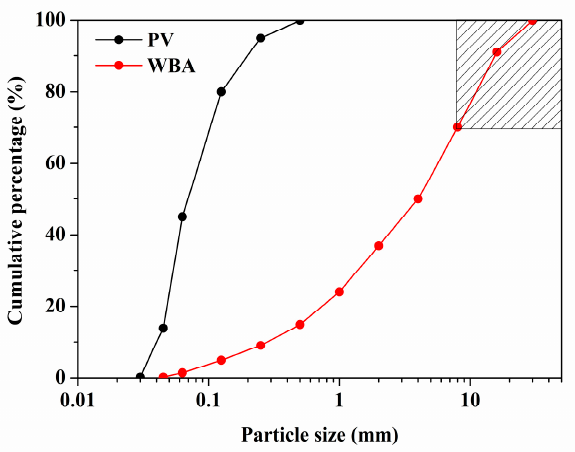
Figure 1. Particle size distribution (PSD) of weathered bottom ash (WBA) and PAVAL ® (PV).